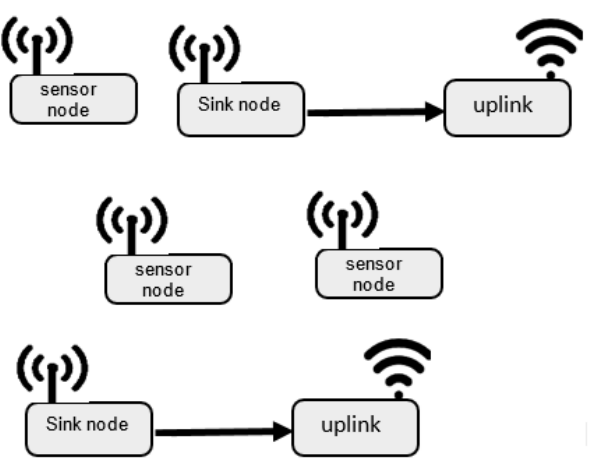
Figure 1 Illustration of a Wireless Sensor Network